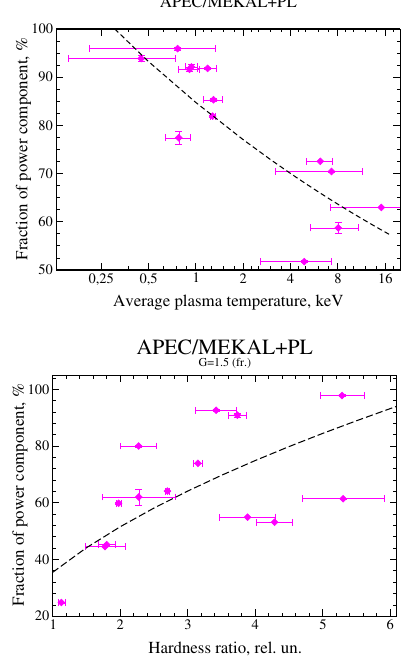
Figure 9. Dependence between the fraction of power component vs. plasma temperature from the APEC/MEKAL+PL model ( top panel ) and vs. hardness ratio (bottom panel) for γ Cas